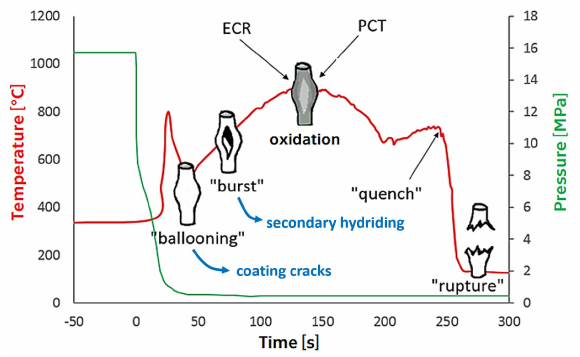
Figure 1. The schematic overview of LB-LOCA accident.